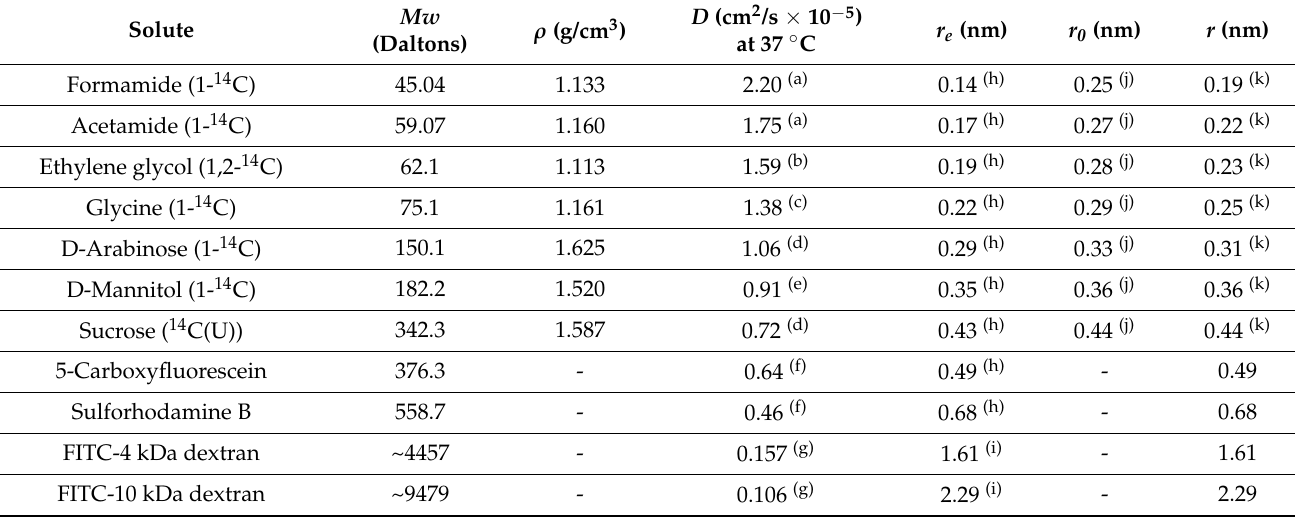
Table 1. Physicochemical properties of hydrophilic